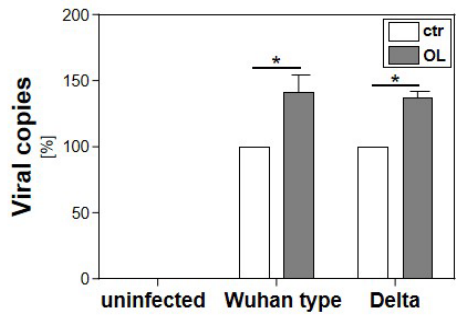
Figure 2. Effect of cellular lipid accumulation on the replication of SARS-CoV-2 Wuhan type or Delta. Calu-3 cells were incubated with 0.6 mM oleate for 5 h prior to infection with the SARS-CoV-2 Wuhan type or the VoC Delta (MOI of 2 × 10 − 2 for 1 h). Cell culture supernatants were harvested three days post infection. The virions were purified and analyzed by qRT-PCR. Bars show mean values of three independent experiments ± SEM (*: p < 0.05).